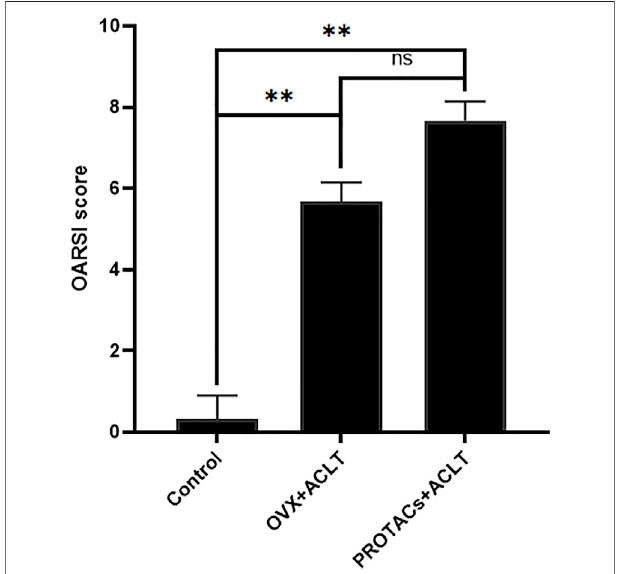
FIGURE 6 | Histological scores of articular cartilage were quantitatively assessed based on the severity of cartilage damage. Cartilage destruction was scored in a blinded manner by 3 observers using the OARSI grading